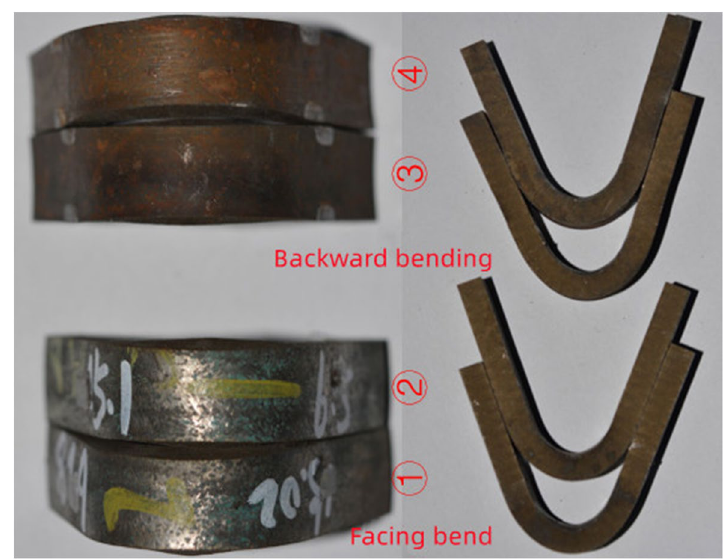
Fig. 3 Specimen after bend testing experiment